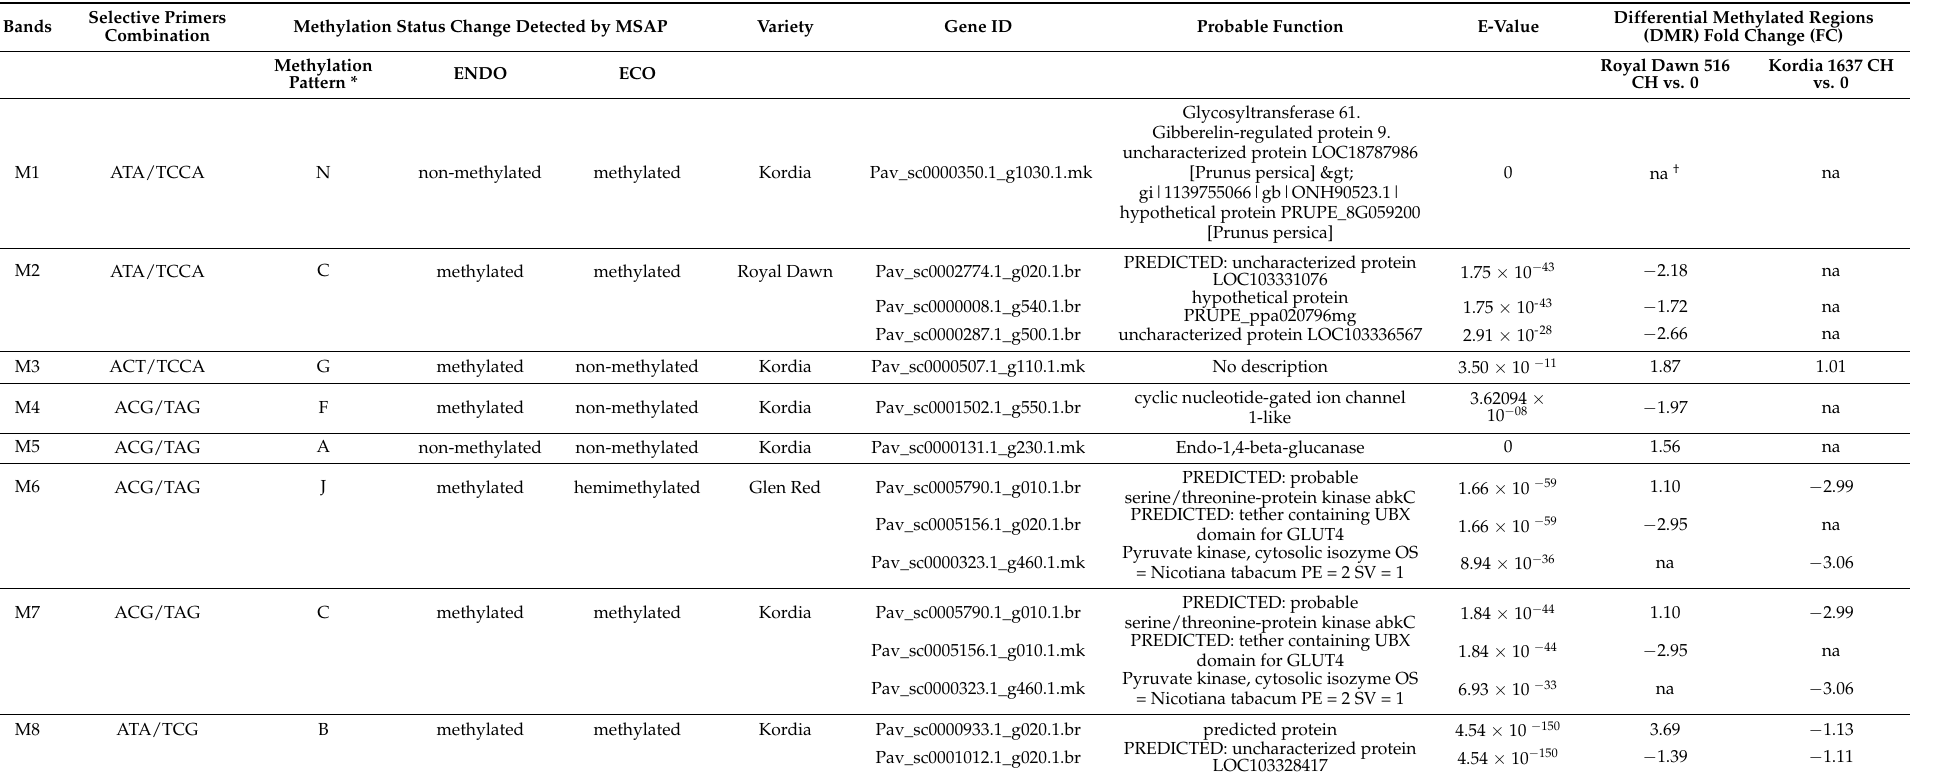
Table 5. List of sequenced MSAP bands identified at ENDO and ECO stages, isolated from sweet cherry varieties at different chilling hours (CH) accumulation. The banding pattern categories are described according to Karan et al.,